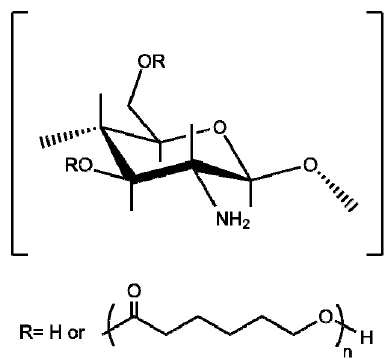
Figure 7. Chemical structure of chitosan- g -poly( ε -caprolactone).